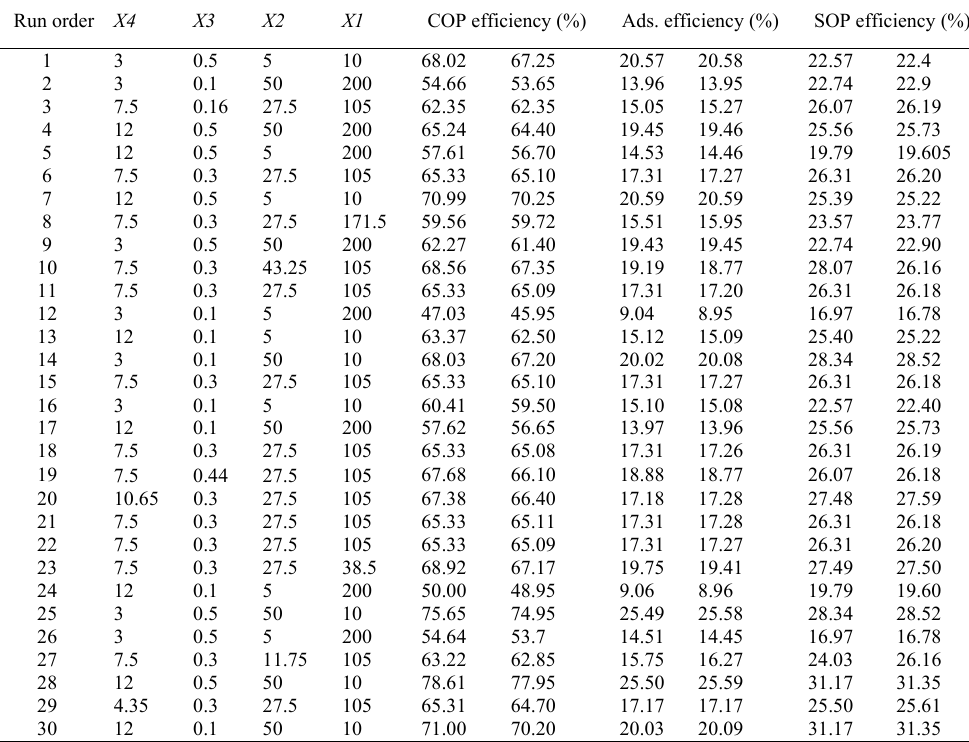
Table 2: Design of the experiment and its results